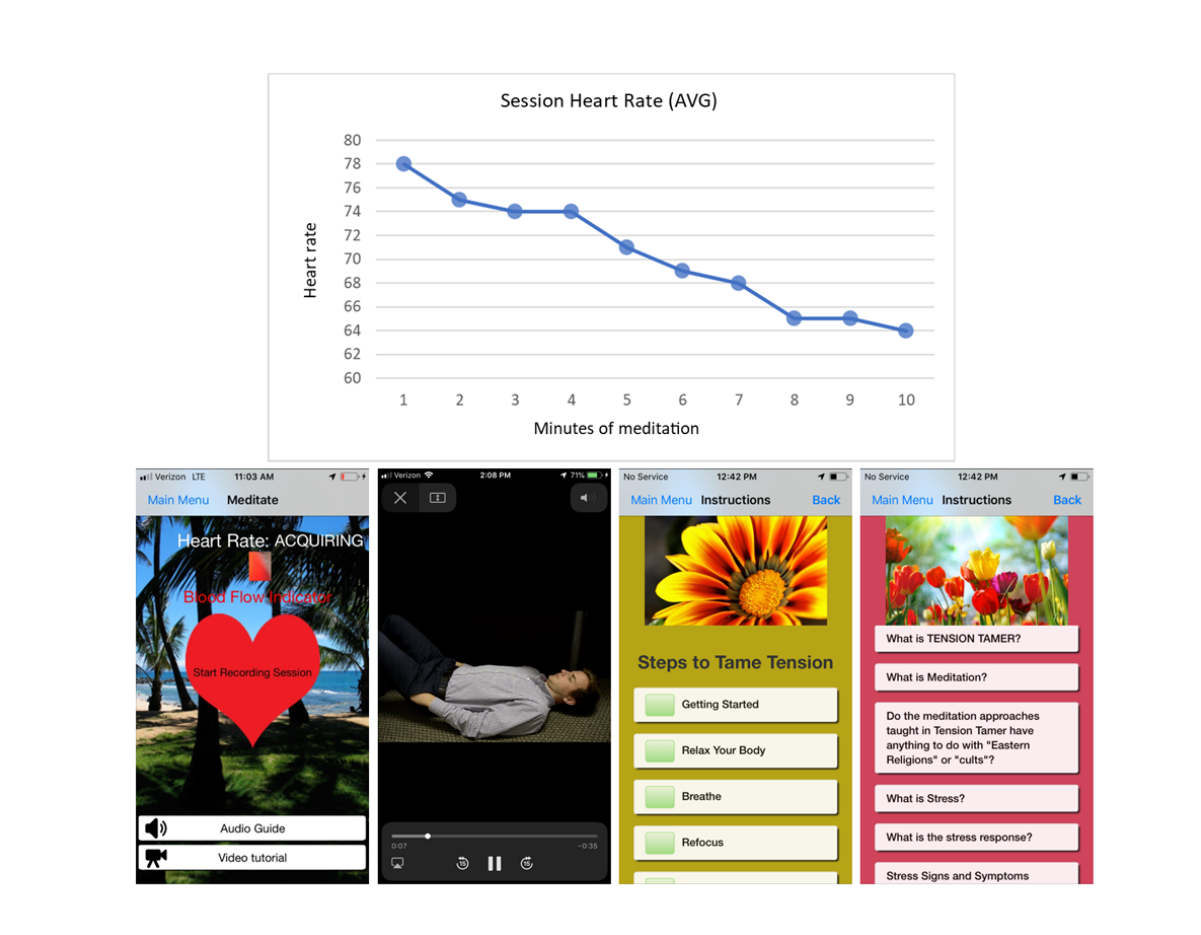
Figure 1. The graphical heart rate feedback after each Tension Tamer session to illustrate average heart rate changes across each minute using the smartphone’s camera (top). Screenshots of the home screen (bottom), breathing meditation instructions, information regarding how Tension Tamer works, and a frequently asked questions